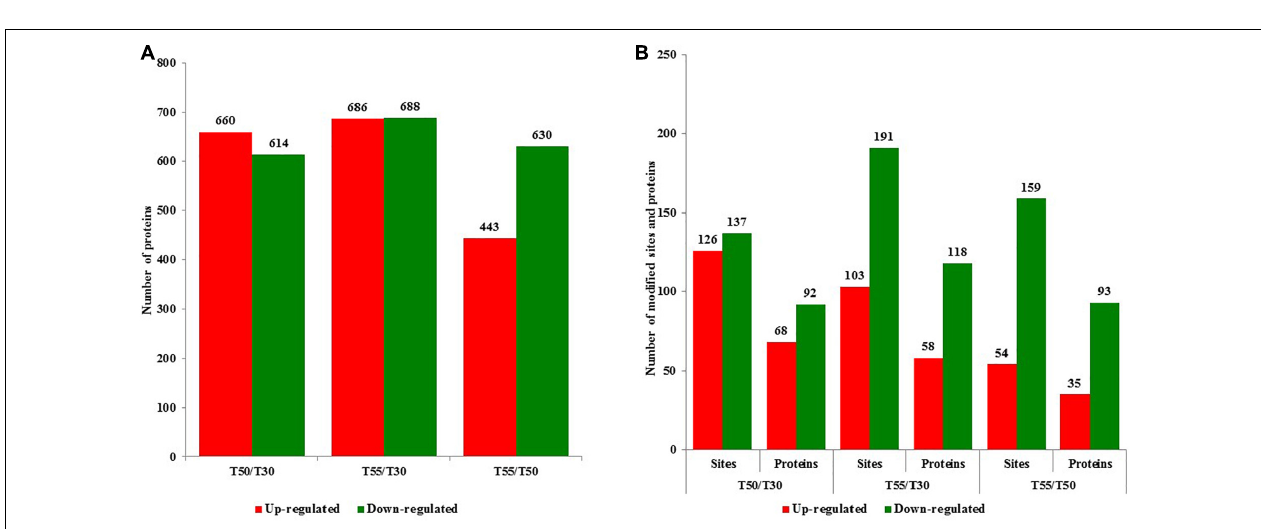
FIGURE 1 | Growth of C. thermophilum and SDS-PAGE of cell proteins. (A) Growth of C. thermophilum at different temperatures, 25, 30, 35, 40, 45, 50, 55, and 60 ◦ C, after 3 days. (B) SDS-PAGE of cellular proteins from C. thermophilum mycelia growing at three different temperatures 30 ◦ C (T30), 50 ◦ C (T50), and 55 ◦ C (T55). Each sample was loaded in triplicate, as indicated by labels 1, 2, and 3; Lane M, molecular mass markers.